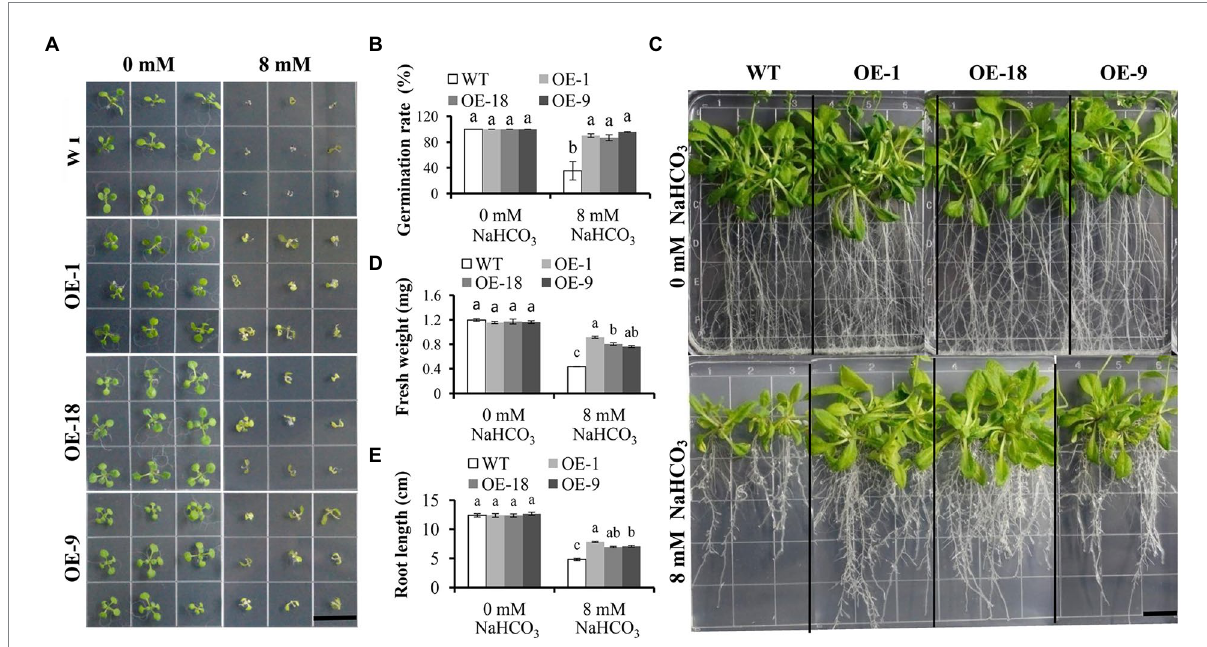
FIGURE 4 Effect of GmNHX6 overexpression on Arabidopsis tolerance to NaHCO 3 treatment. (A) Seed germination assay of different Arabidopsis lines on 1/2 MS medium and 1/2 MS supplied with 8 mM NaHCO 3 . Photographs were taken 7 days after NaHCO 3 treatment. WT: wild type; OE-1, OE-18, OE-9: Arabidopsis lines overexpressing GmNHX6 . Bar = 1.5 cm. (B) Seed germination rates of different Arabidopsis lines as shown in A. Data represents the mean ± standard deviation of three biological replications and each repeat contained 36 seeds per line for each treatment ( n = 36 × 3 = 108). (C) Phenotypes of Arabidopsis lines subjected to 0 and 8 mM NaHCO 3 treatment, respectively. Seeds were grown vertically on 1/2 MS agar plates supplemented with 0 or 8 mM NaHCO 3 for 10 days after seven days of normal growth. Bar = 1.5 cm. (D,E) Fresh weight and root length of Arabidopsis lines as shown in (C) . Data represents the mean ± standard deviation of three biological replications and each repeat contained four plants per line for each treatment ( n = 12). Bars with the same letter in lowercase above bars indicate no significant differences at the 0.05